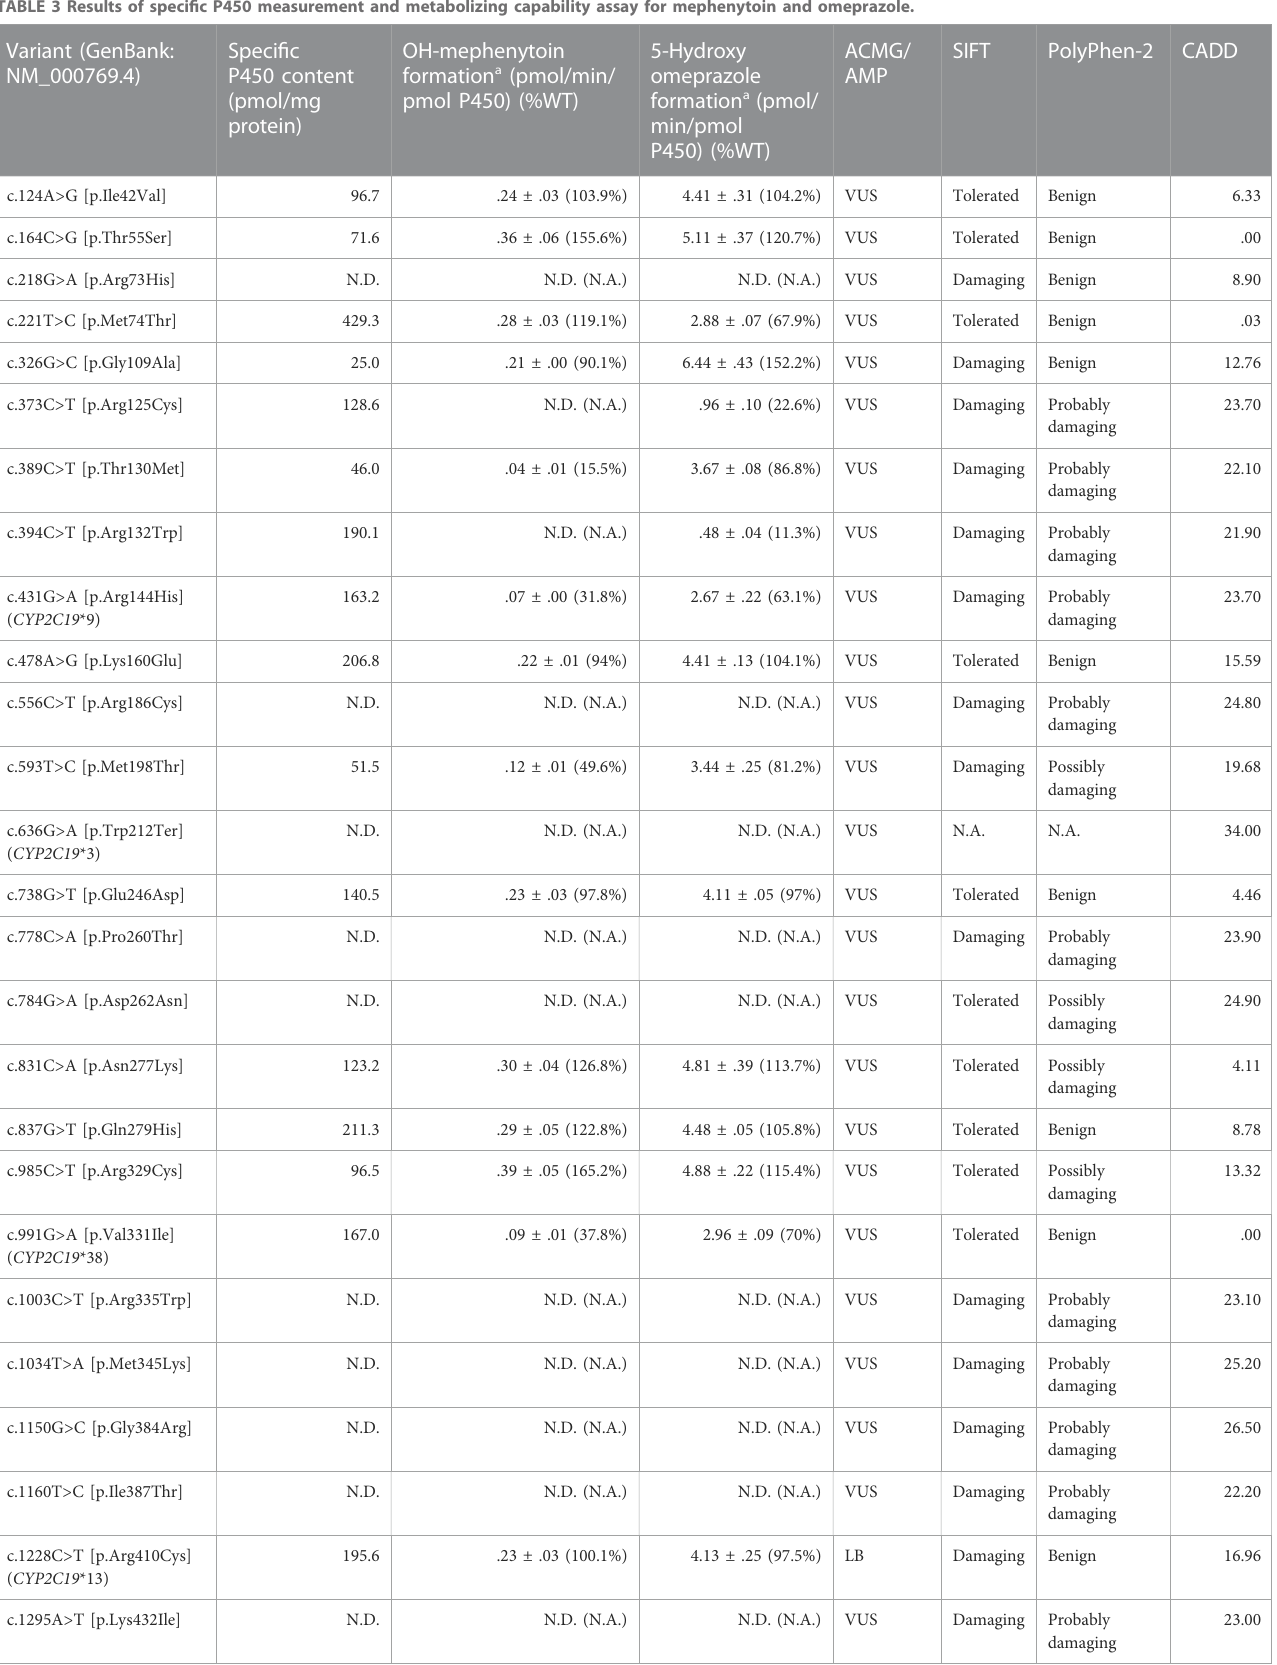
TABLE 3 Results of speci fi c P450 measurement and metabolizing capability assay for mephenytoin and omeprazole. Variant (GenBank: